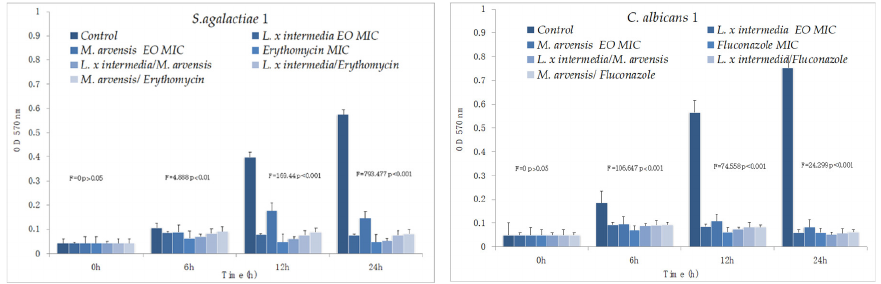
Table 2. Minimum inhibitory concentration (MIC) of EOs in comparison with the two reference antimicrobials (erythromycin and fluconazole). Data are expressed as μg/mL.